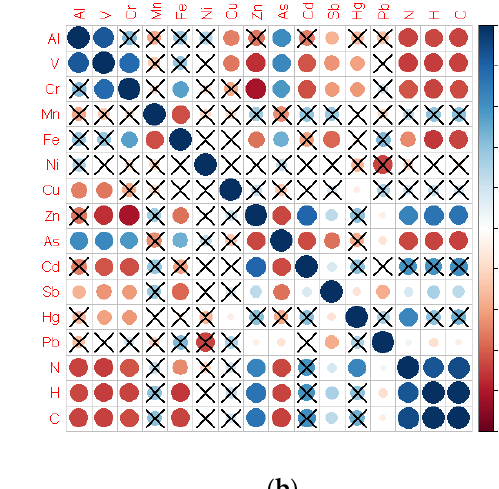
Figure 5. Correlation plot June ( a ) and October ( b ). Size of the point indicates the strength of the correlation, blue—positive, red—negative correlation; crossed points indicate non-significant correlations.